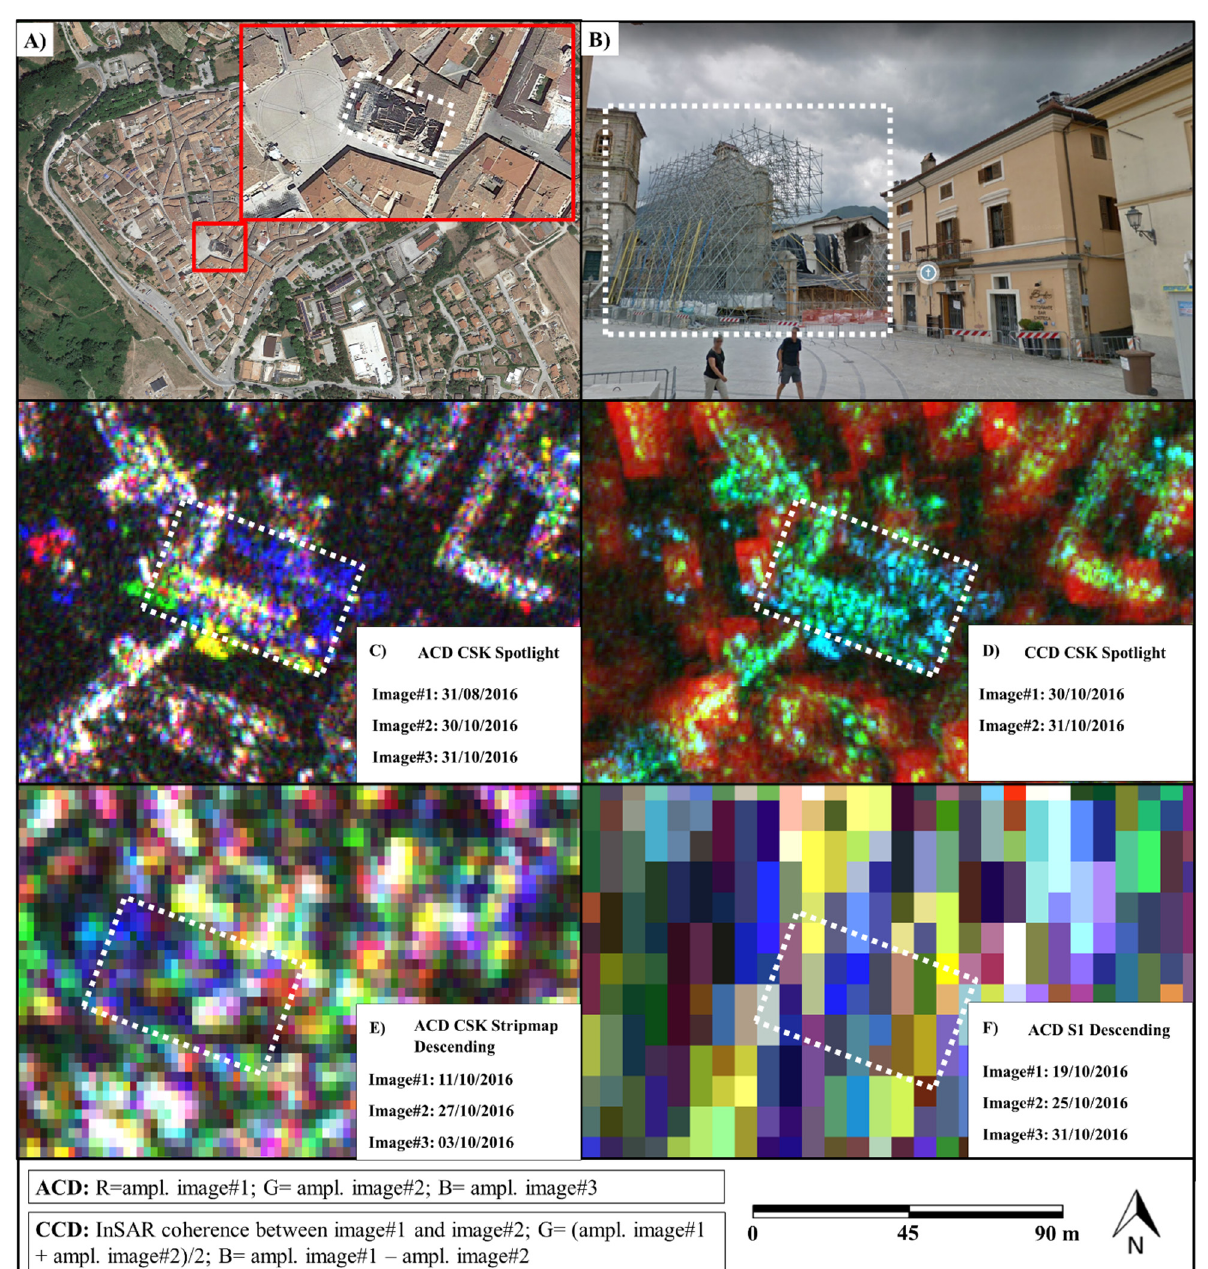
Figure 5. Extracts of the San Benedetto Church in Norcia. ( A , B ) Locations and post-earthquake pictures of the church (source: Google); ( C ) ACD Spotlight COSMO-SkyMed; ( D ) CCD Spotlight COSMO-SkyMed; ( E ) ACD StripMap COSMO-SkyMed descending; and ( F ) ACD IW Sentinel-1 descending.